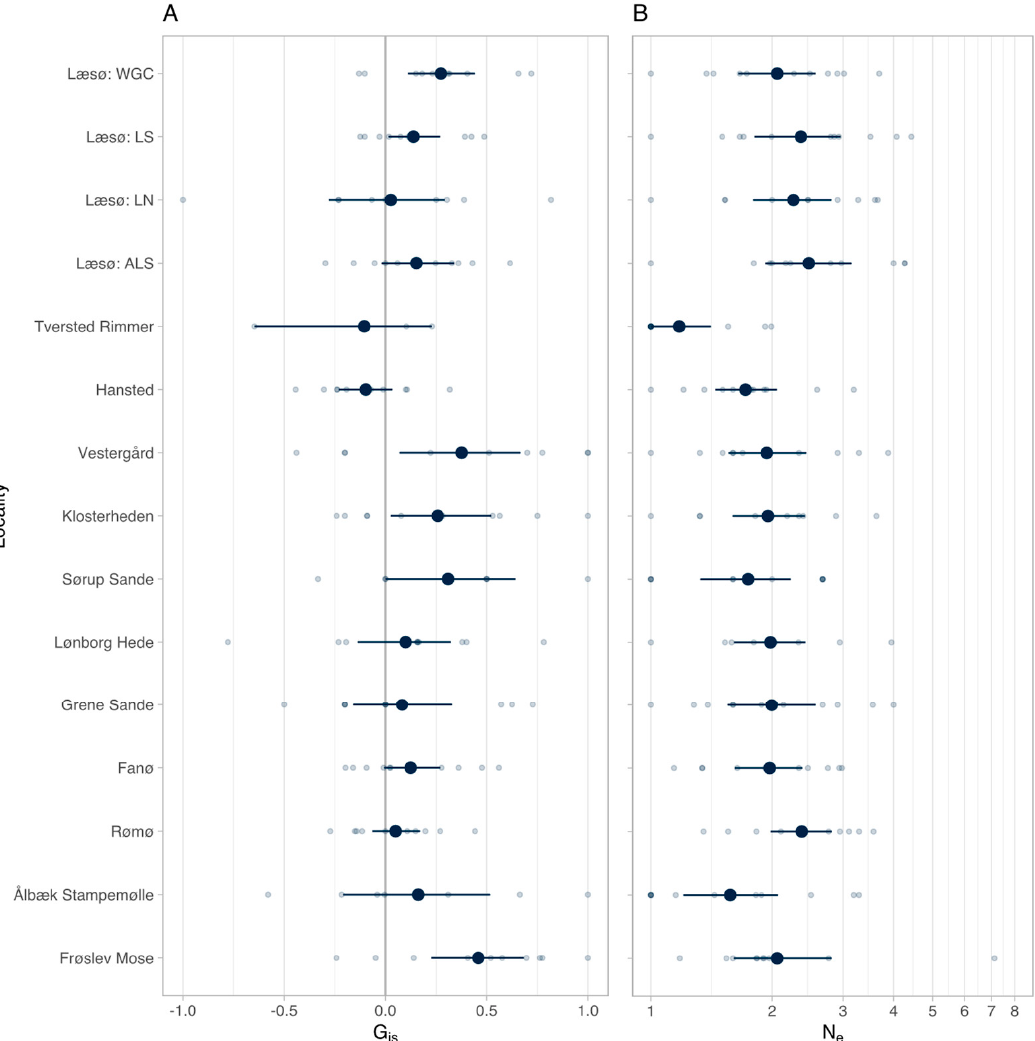
Figure 7. Estimates of genetic diversity of contemporary populations with 95% jackknife confidence intervals. Populations are ordered to approximately reflect their occurrence next to each other geo- graphically. ( A ) Coefficient of inbreeding, ( B ) effective number of alleles; note the log 2 -transformation of the x-axis.